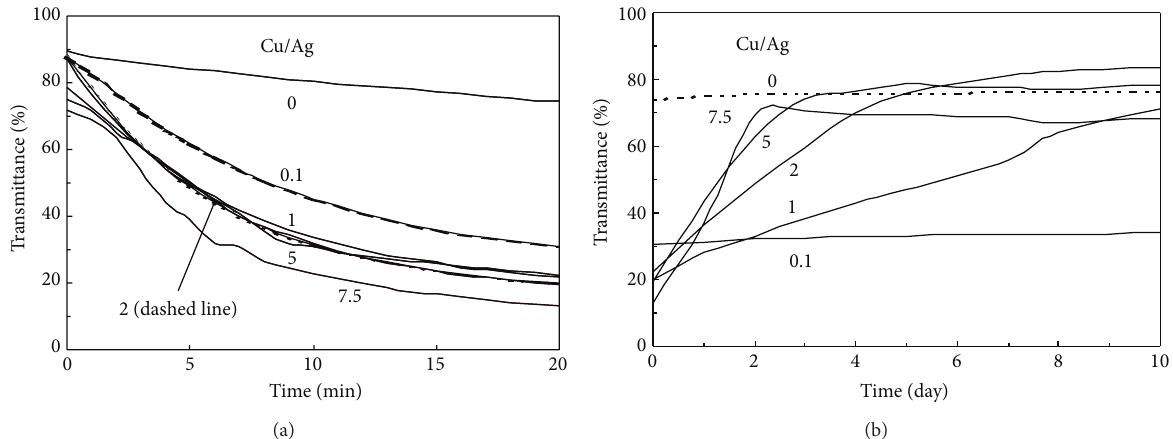
Figure 2: Coloring and bleaching properties of the composite films with different Cu/Ag ratios and the employed wavelength of 450 nm.